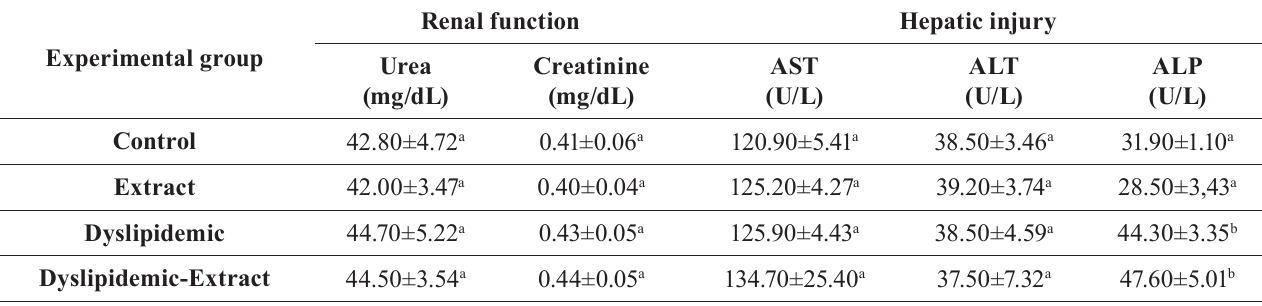
TABLE III - Effect of Coffea arabica L. leaf extract on the renal function and hepatic injury in non-dyslipidemic and dyslipidemic animals